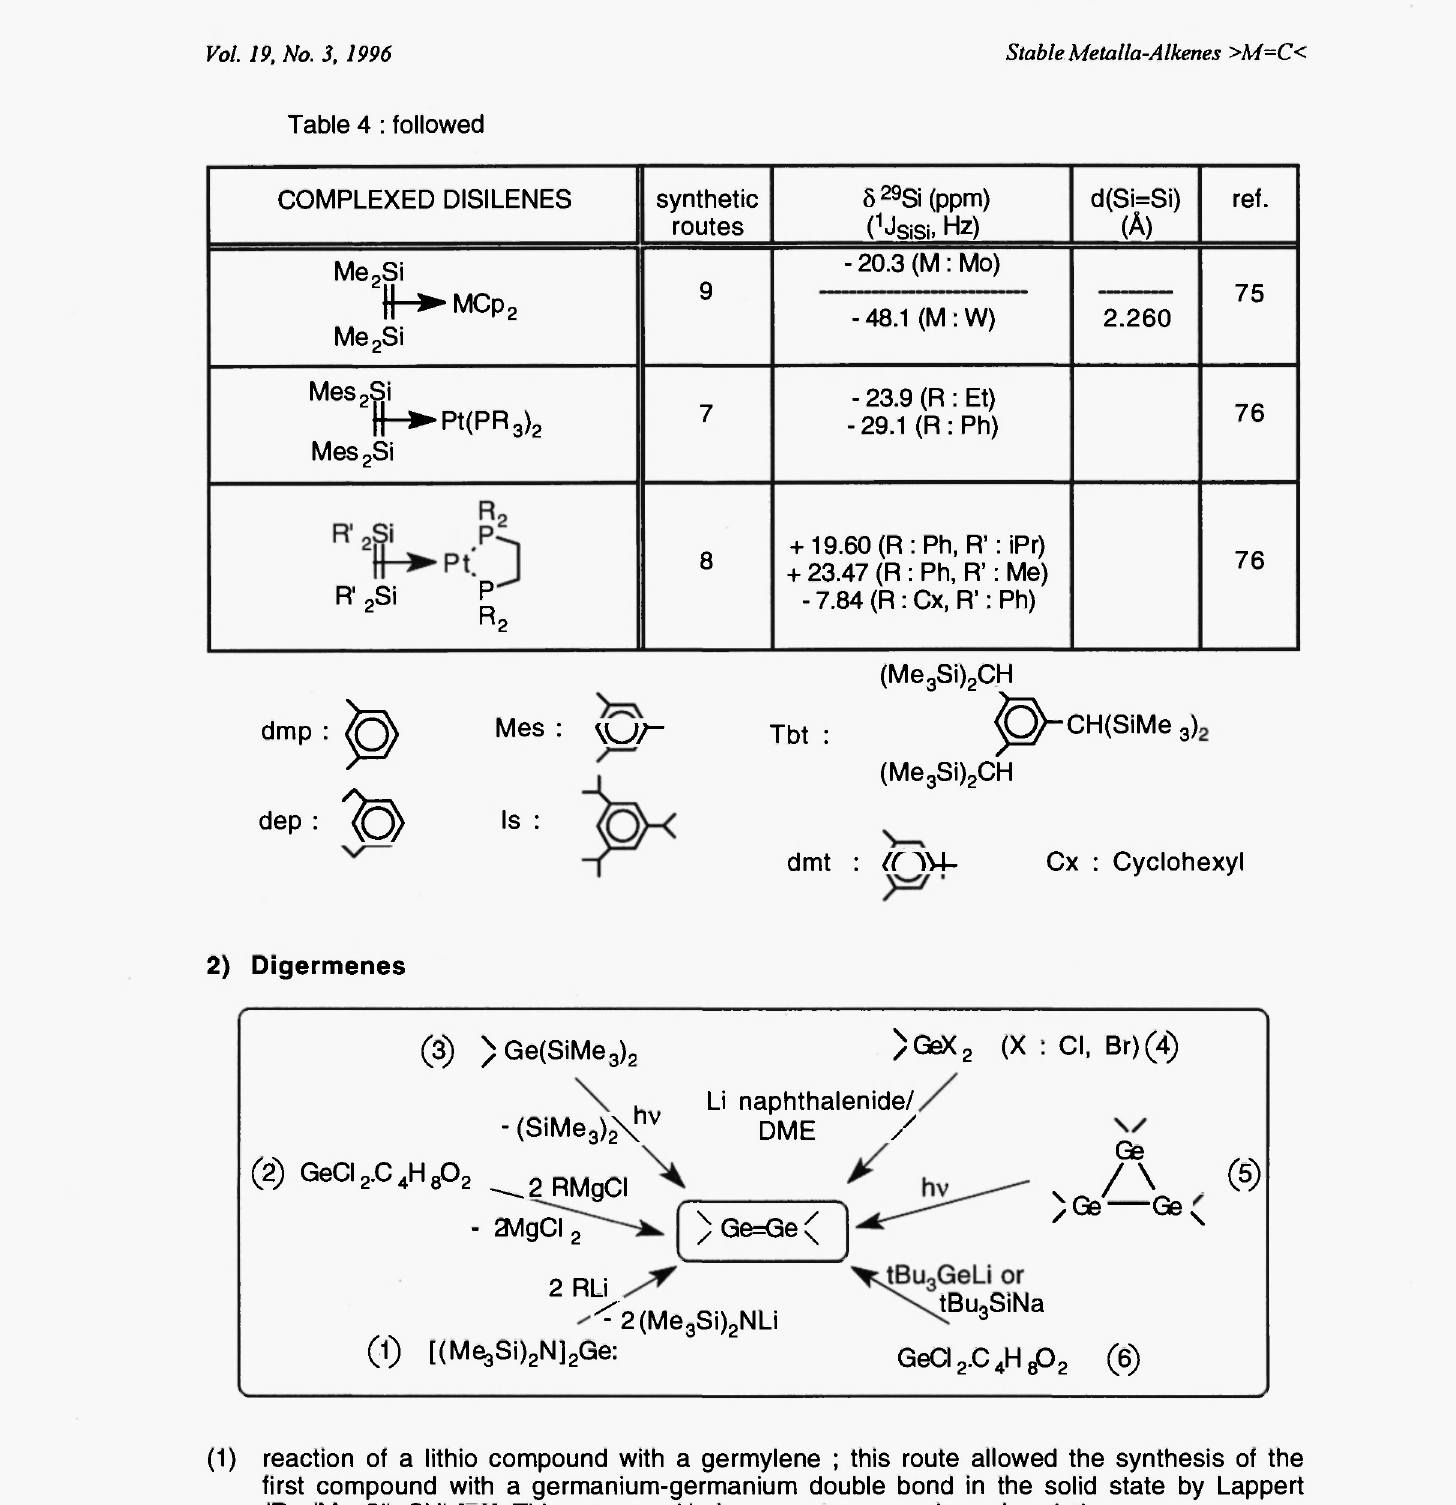
Table 4: followed COMPLEXED DISILENES synthetic